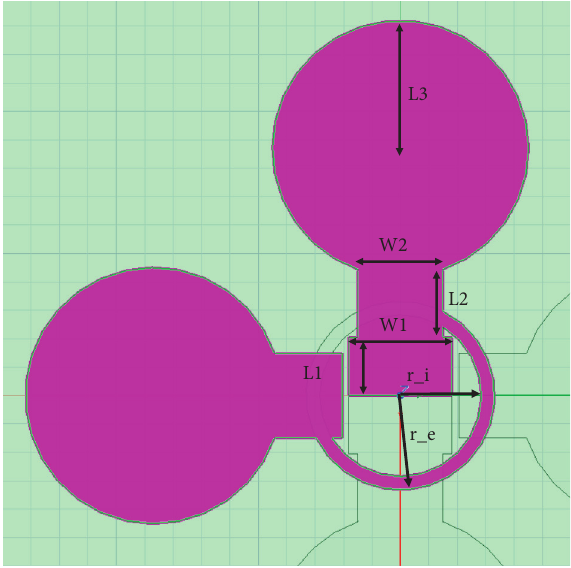
Figure 2: Geometry dimensions considered for UCPCA optimization.